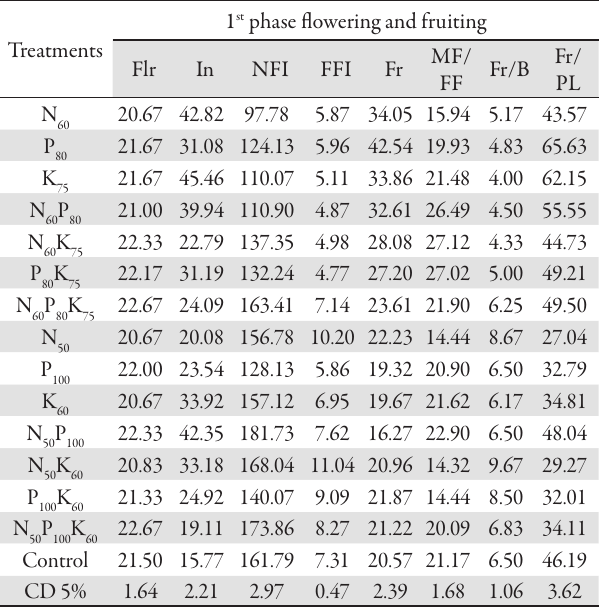
Tab. 2. Effect of N, P and K on 1st phase flowering and fruiting of Jatropha (Pooled)